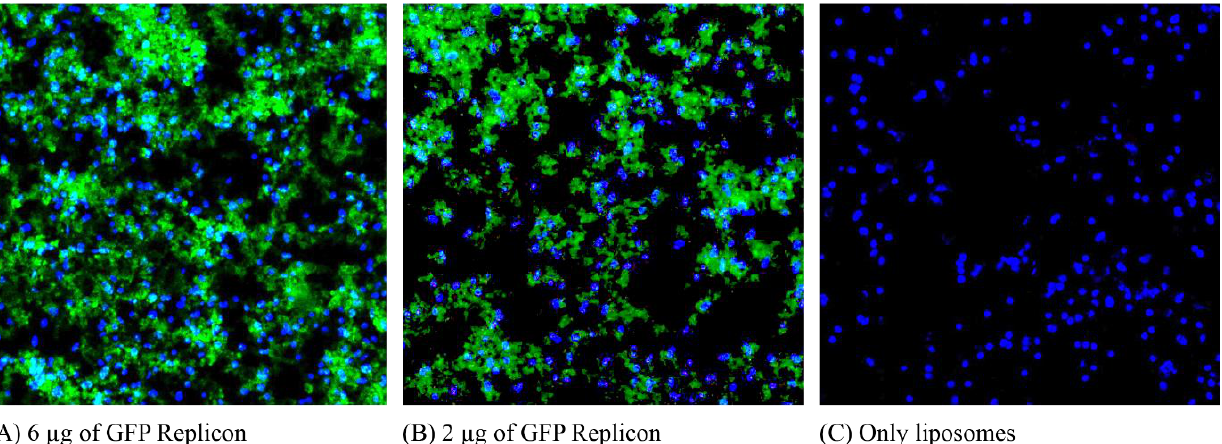
Figure 3. Vero cells were easily transfected with packaged samRNA encoding GFP. Comparison of Vero cells transfected with ( A ) 8 nM of cationic liposomes conjugated with 6 µ g of samGFP RNA; ( B ) 8 nM of cationic liposomes conjugated with 2 µ g of samGFP; ( C ) only liposomes. The nuclei were stained with DAPI, and the green cytoplasm of the transfected cells indicates GFP expression. Images were captured at 40× magnification.